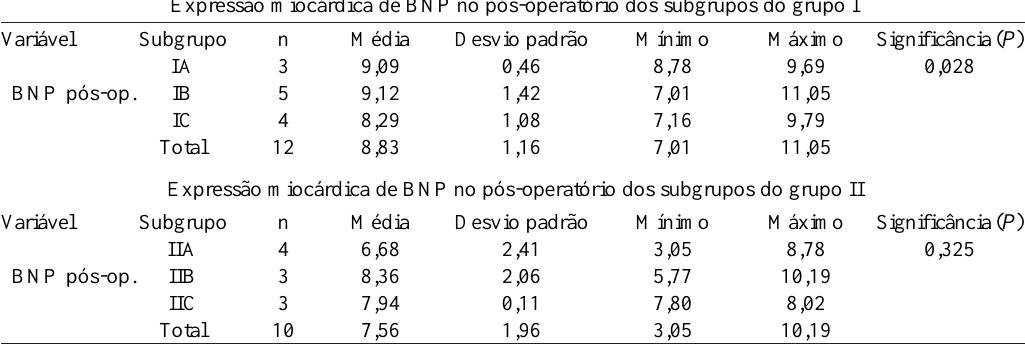
Tabela 3. Expressão miocárdica de BNP nos grupos I e II